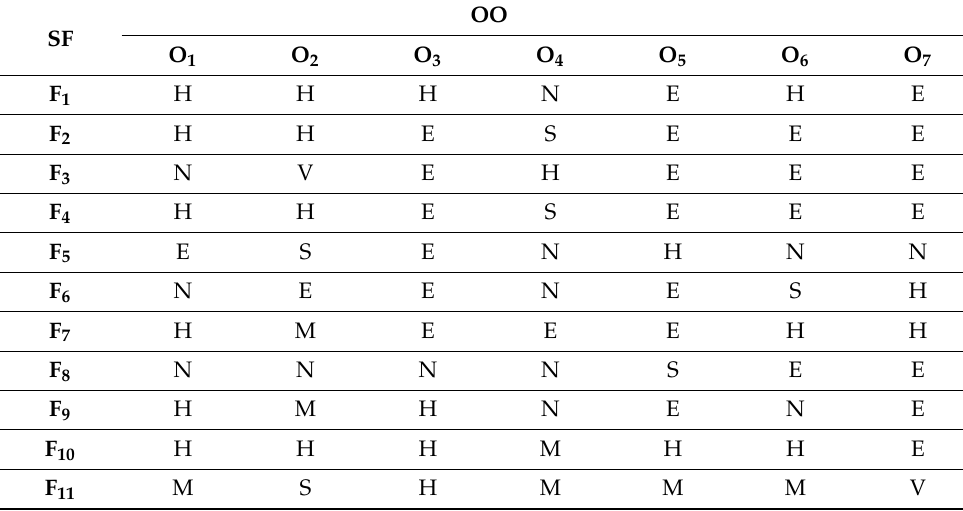
Table 5. Fuzzy relation matrix—SFs to OOs—Linguistic values judgments.